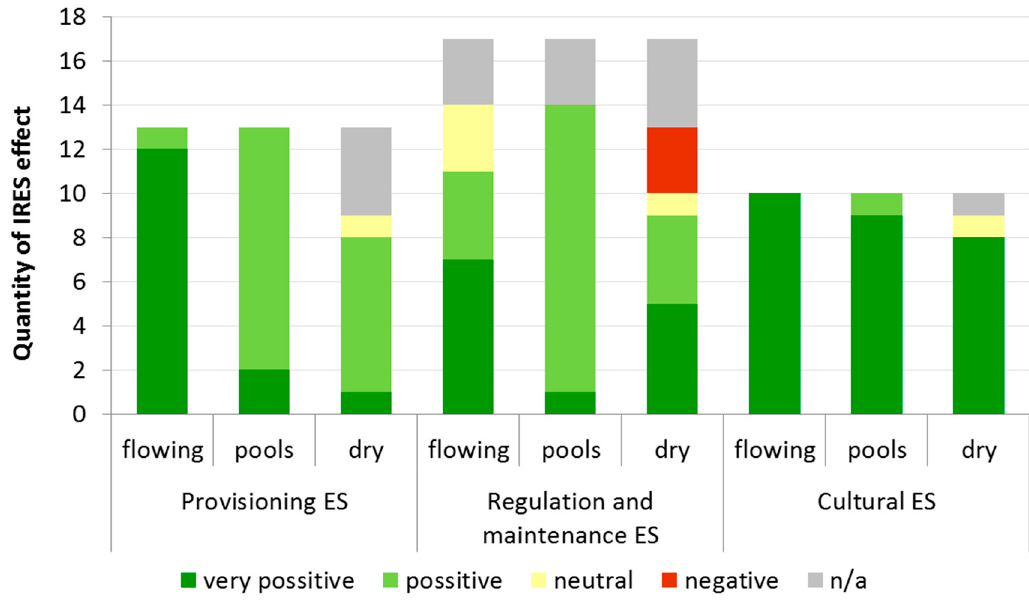
Figure 2. Quantity of IRES effects within the groups of ES.